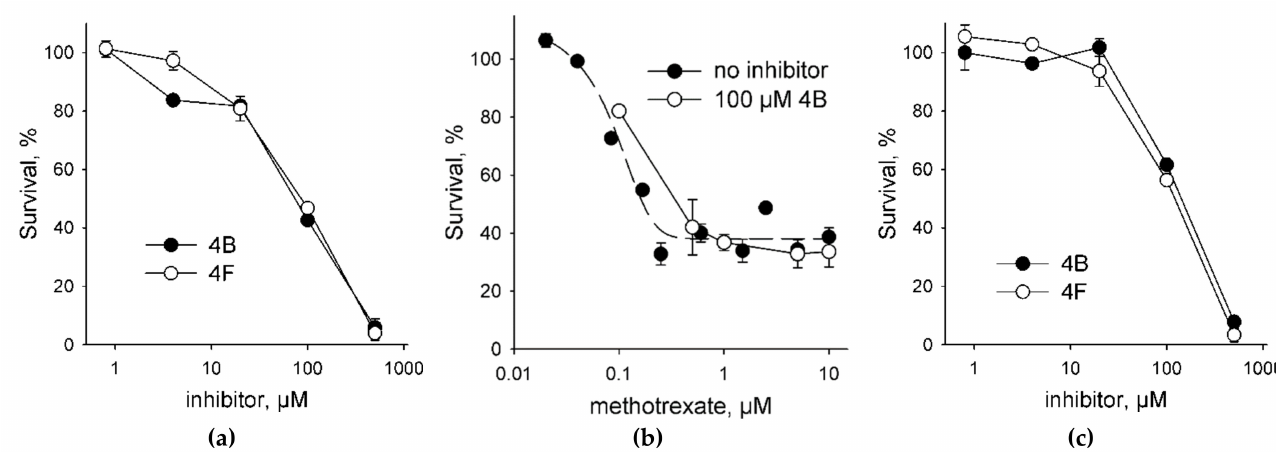
Figure 4. Cytotoxicity of UNG inhibitors. ( a ) Survival of HEK 293FT cells in the presence of the UNG inhibitors 4B and 4F (0.8–500 µ M); ( b ) survival of HEK 293FT cells in the presence of MTX alone (0.02–10 µ M) or 100 µ M 4B plus MTX (0.1–10 µ M); ( c ) survival of HEK 293FT cells in the presence of the UNG inhibitors 4B and 4F (0.8–500 µ M) plus 0.1 µ M MTX. In Panel C, the survival in the presence of 0.1 µ M MTX alone is taken for 100%. Mean ± s. e. m. is shown ( n =